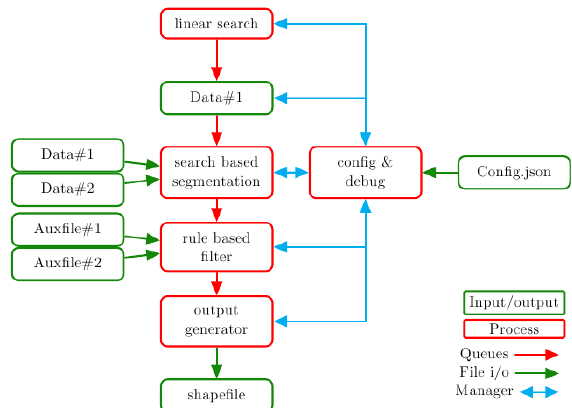
Figure 1: An architecture of the processing pipeline